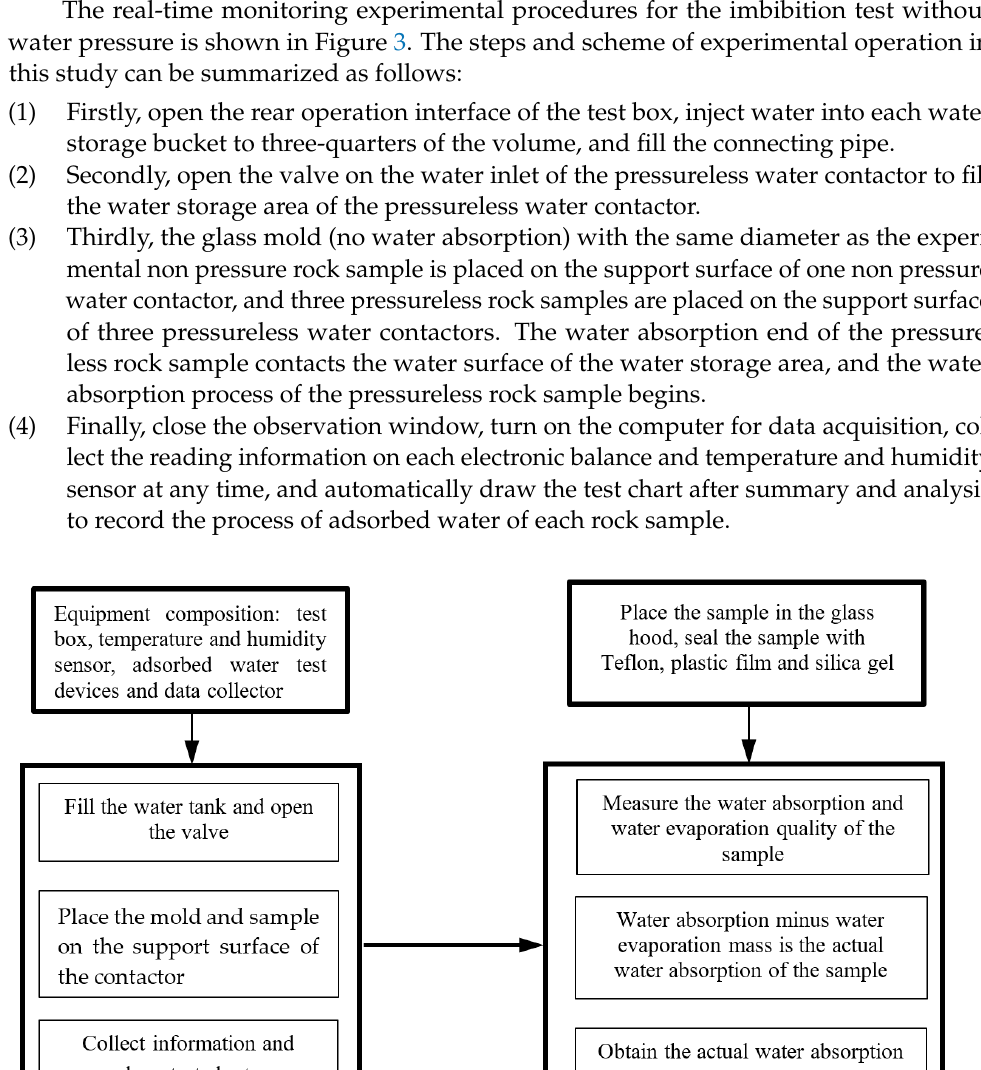
Figure 2. Sketch for real-time monitoring experimental system for imbibition test without water pressure.